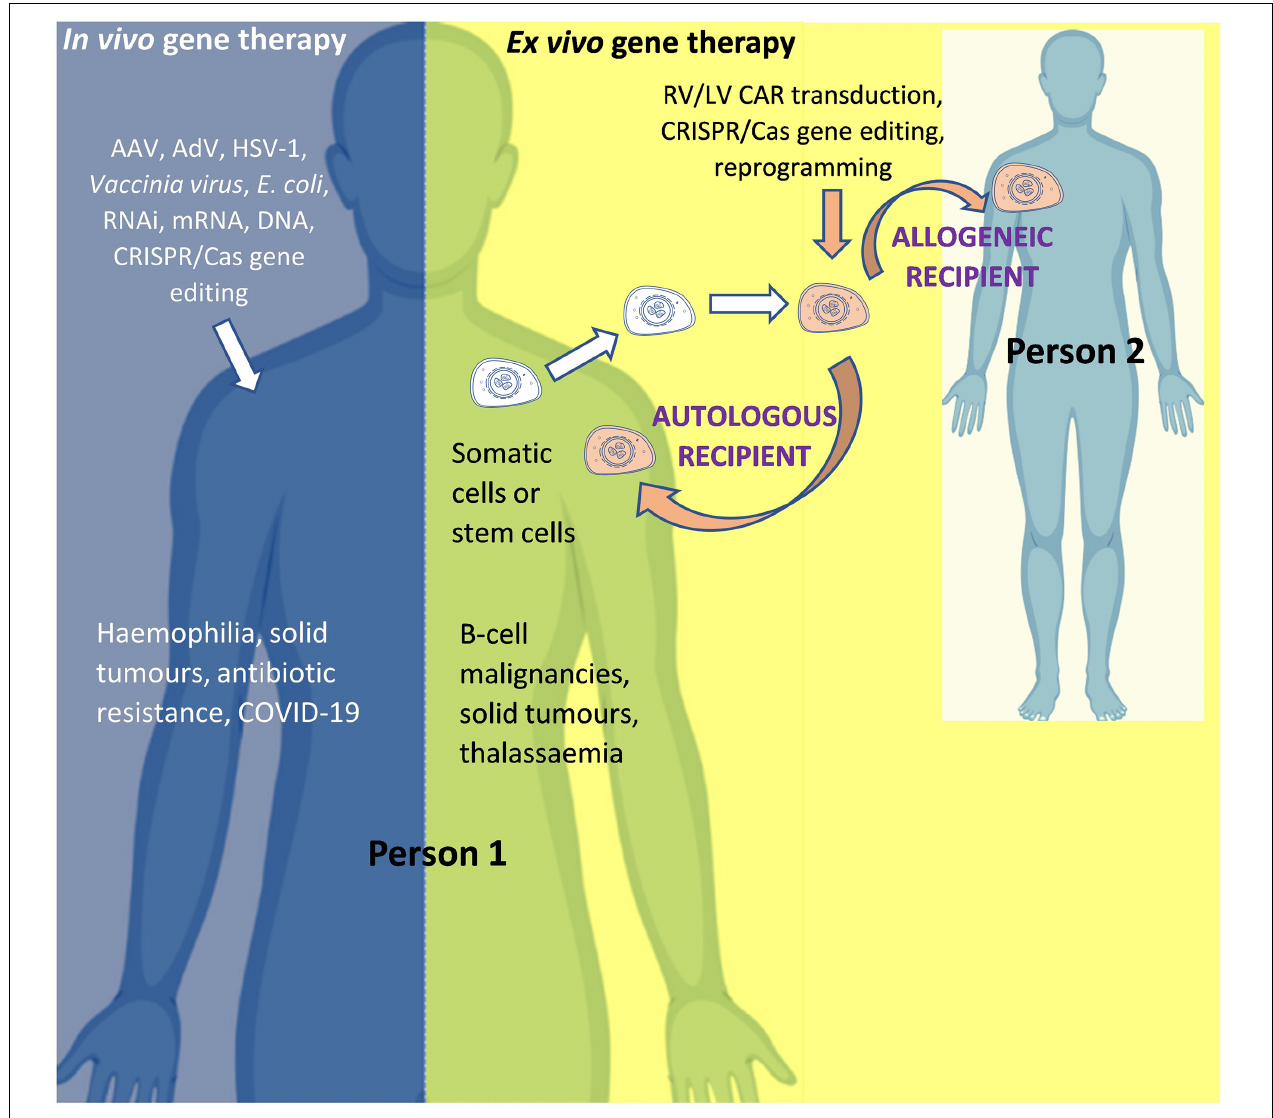
FIGURE 3 | In vivo and ex vivo gene therapy. AAV, Adeno-associated virus ; AdV, Adenovirus ; Cas, CRISPR associated protein; CAR, Chimeric Antigen Receptor; COVID-19, Coronavirus Disease 2019 caused by Severe Acute Respiratory Syndrome Coronavirus 2 (SARS-CoV-2); CRISPR, Clustered Regularly Interspaced Short Palindromic Repeats; HSV-1, Herpes simplex virus 1 ; LV, Lentiviral vector; mRNA, messenger RNA; RNAi, RNA interference; RV, Retroviral vector. Person 1 is the patient if the product is for (“autologous”) use in that same person OR is a healthy donor if the product is for (“allogeneic”) use in another person (Person 2). For in vivo gene therapy the modifying gene transfer vector is directly introduced into the body. In ex vivo gene therapy, stem cells (such as hematopoietic stem cells for the treatment of thalassemia) or immune system cells (such as T-cells for the treatment of cancer) can be isolated from the body, modified, and then re-introduced into the body. An allogeneic therapeutic product is manufactured from the biological material of a person other than the patient (as the donor). It can be manufactured for a specific patient under the responsibility of a medical practitioner (as a “directed allogeneic use” product) or for many patients (as an “off-the-shelf”